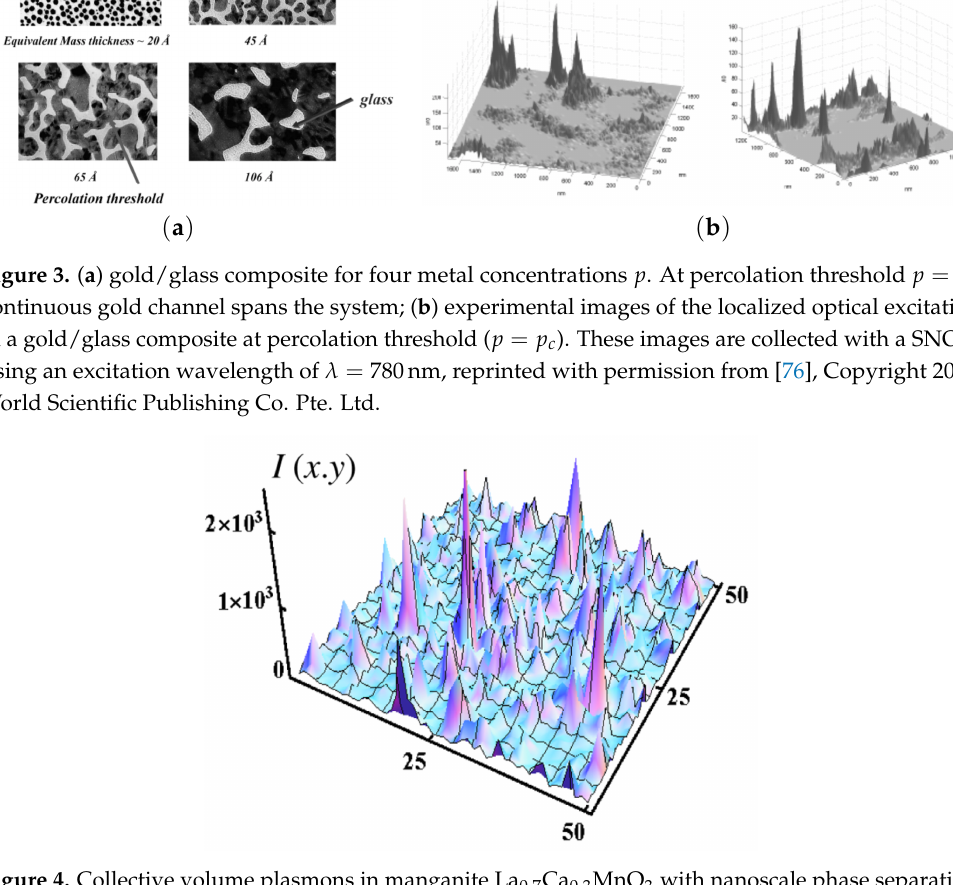
Figure 4. Collective volume plasmons in manganite La 0.7 Ca 0.3 MnO 3 with nanoscale phase separation; computer simulation of infrared electric field I = | E ( x , y ) / E 0 | 2 at volume concentration p = 0.28 > p c of conducting phase; local permittivity ε ( r ) is positive in the dielectric phase Re [ ε ( r )] > 0 and it is negative in conducting phase Re [ ε ( r )] < 0, reprinted figure with permission from [81]; Copyright 2006 by the American Physical